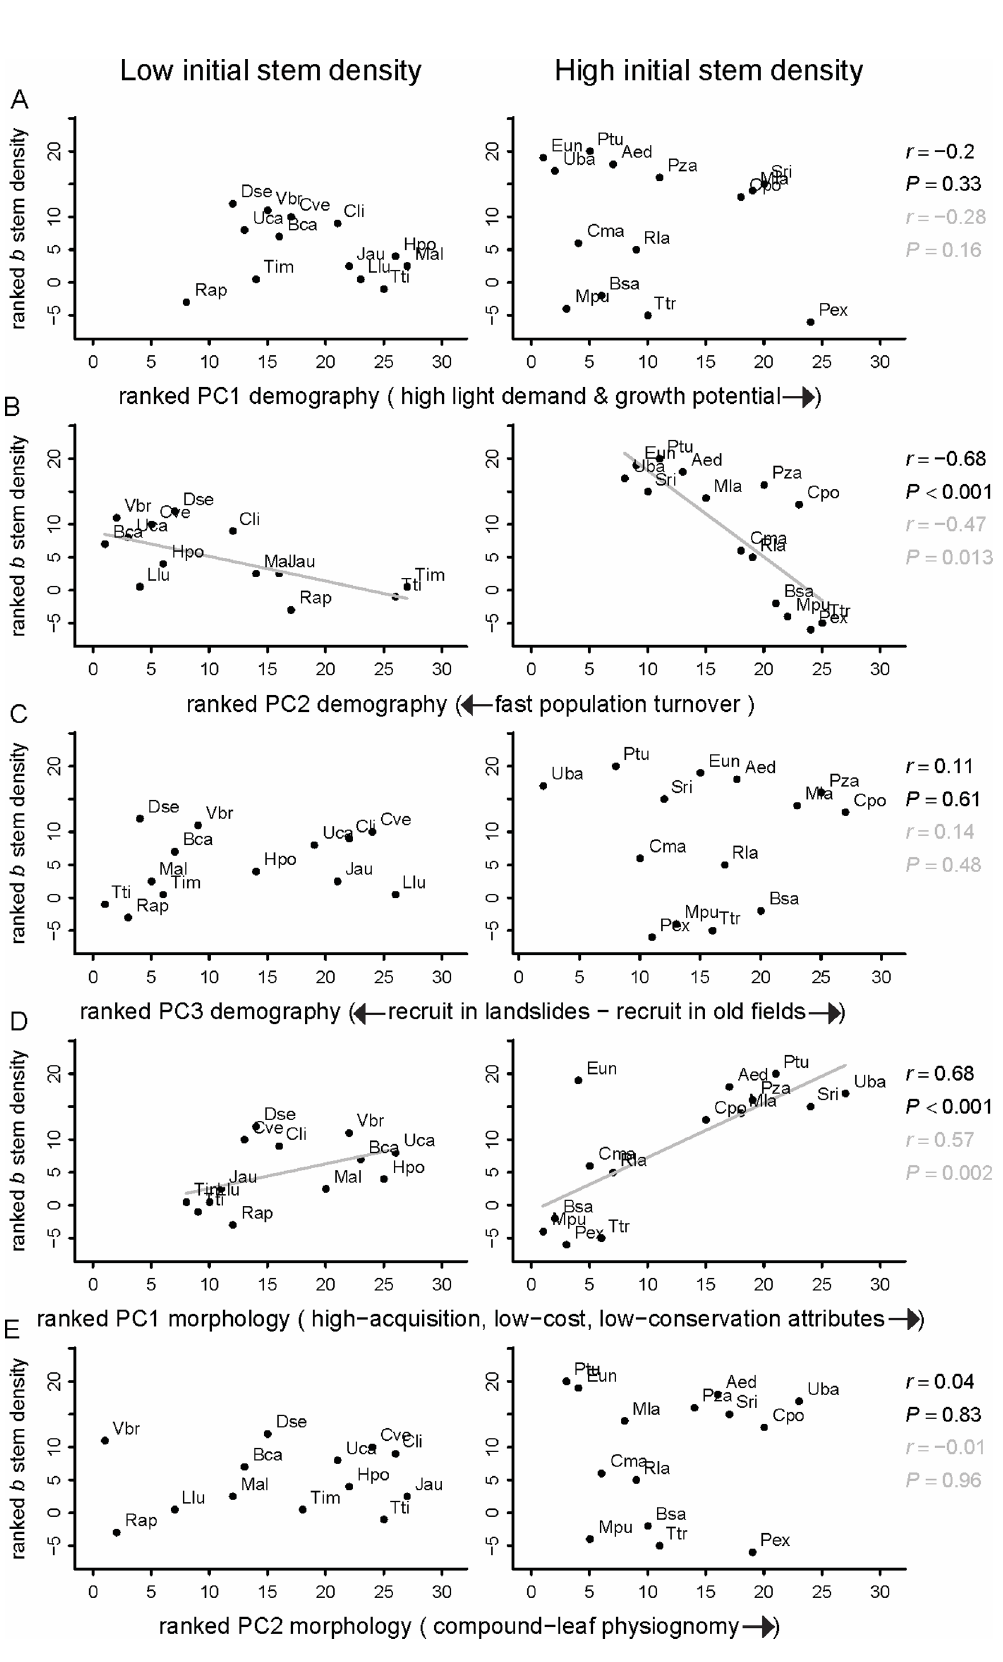
Figure 5. Relationship between stem density changes in 15 years and species life histories and morphological traits. Coplots between the trend of change ( b ) in stem density and demographic and morphological principal components (PC), for low (left) and high (right) initial stem